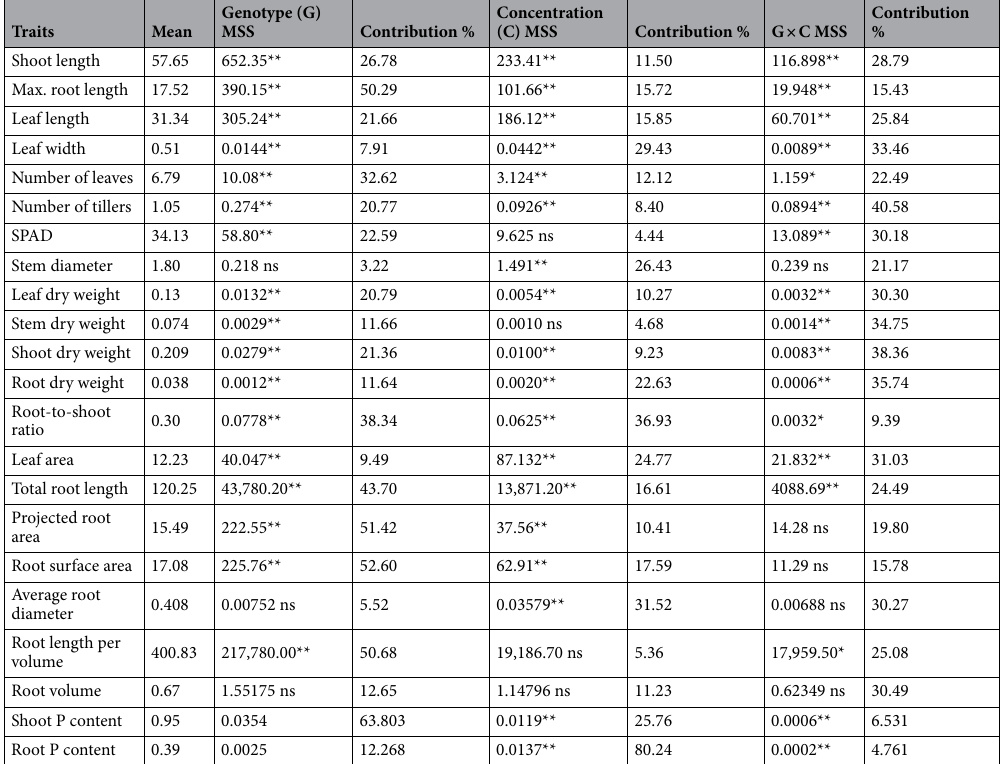
Table 2. Analysis of variance for various traits across different concentrations of phosphorus at 28 d. *Significant at 0.05 level of probability. **Significant at 0.01 level of